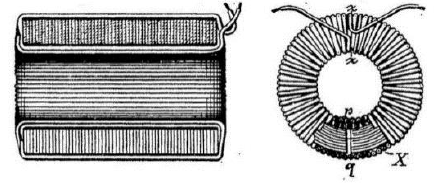
Fig. 8. The design of the load coil M. Pupin. Patent US652231 priority June 19,